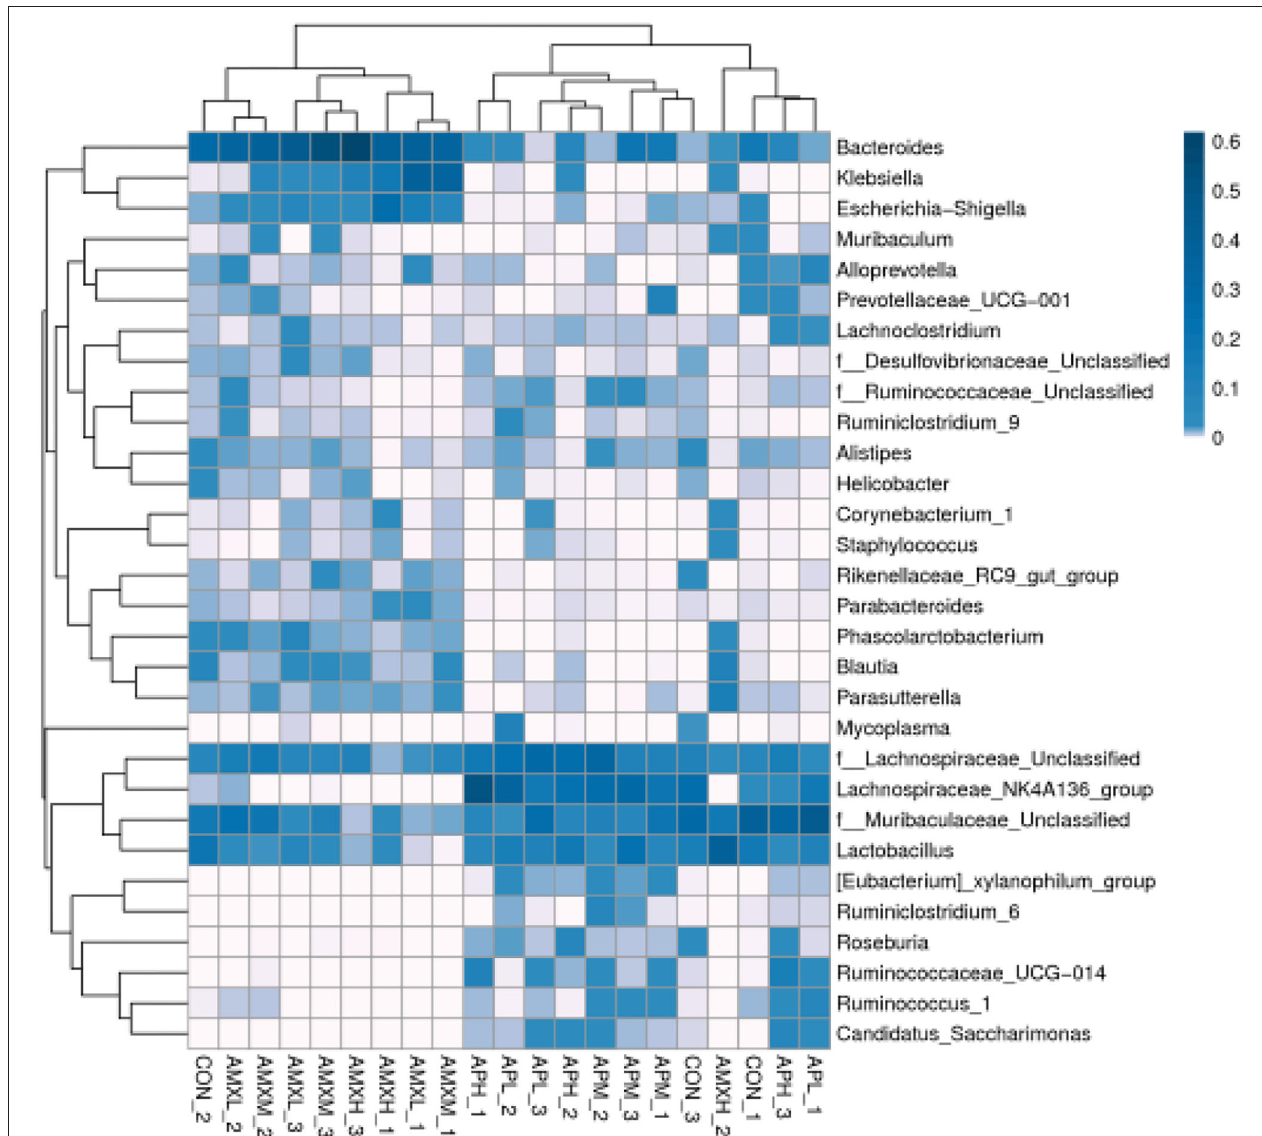
FIGURE 5 | Heatmap of the relative richness of bacterial communities at the genus level. Each color-block in the heatmap represents the relative richness of a bacterial genus in a sample.